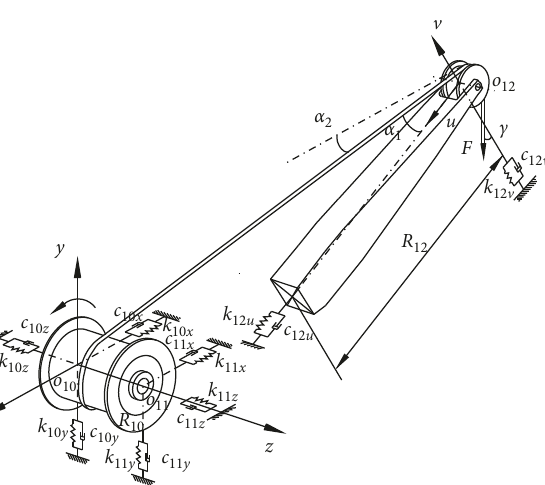
, k are torsional 0405 0708 is torsional stiffness 0910 , k 9 y 9 z and c are the 1303 1406 and c are 0405 0708 , c , c , c 4 z 5 z 7 z 8 z